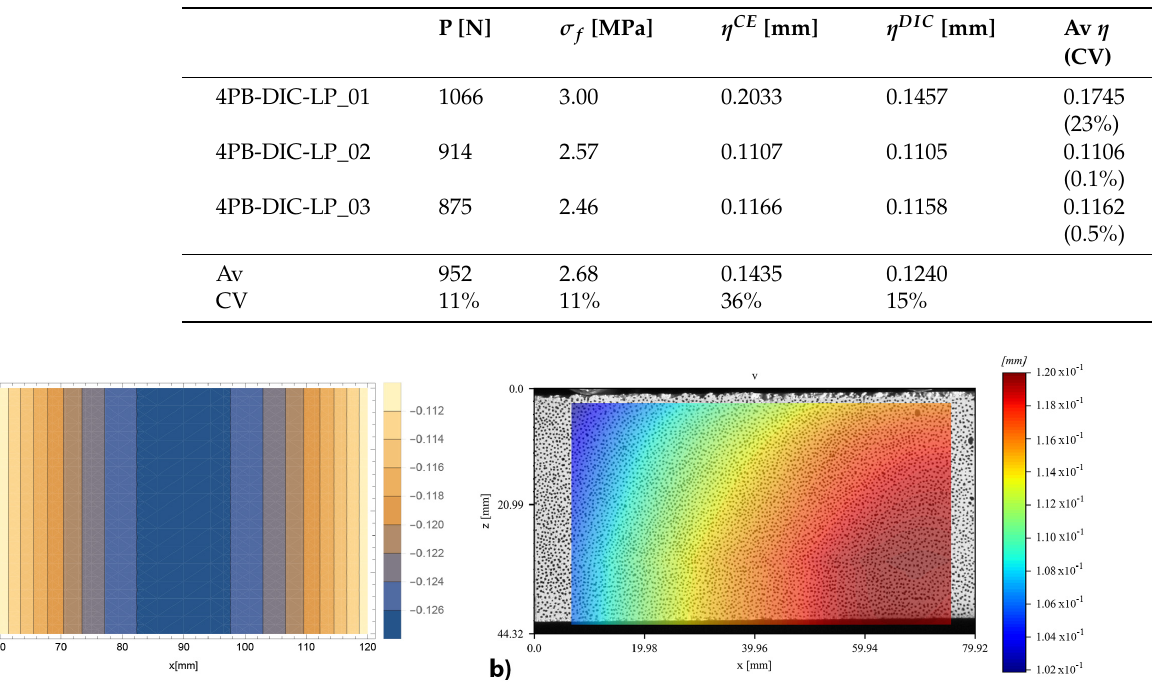
Figure 10. Load–displacement diagrams for four-point bending tests (4PB-DIC-LP). Table 7. Results of four-point bending tests (4PB-DIC-LP) in terms of force and deflection under the loading points (recorded by both cantilever transducer, η CE , and DIC, η DIC ) at peak load P and flexural stress σ f according to the classical mono-modulus beam model.